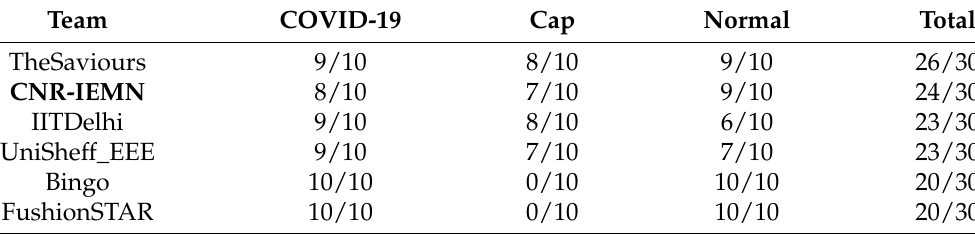
Table 6. First testing split